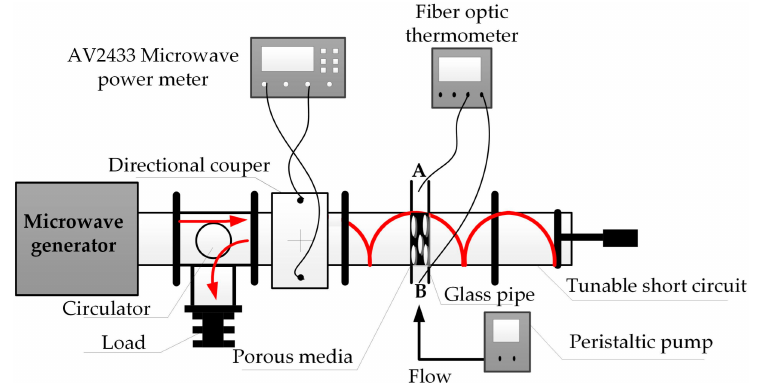
Figure 4. Schematic of experiment setup.